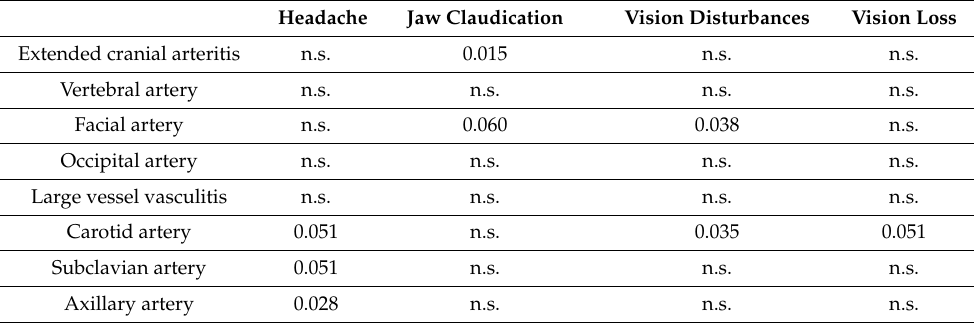
Table 2. Analysis of differential frequencies of clinical parameters and ultrasound-based arterial features in patients with